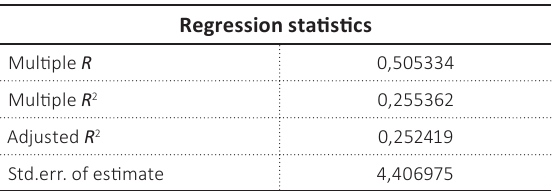
Table 3. Coefficients of determination based